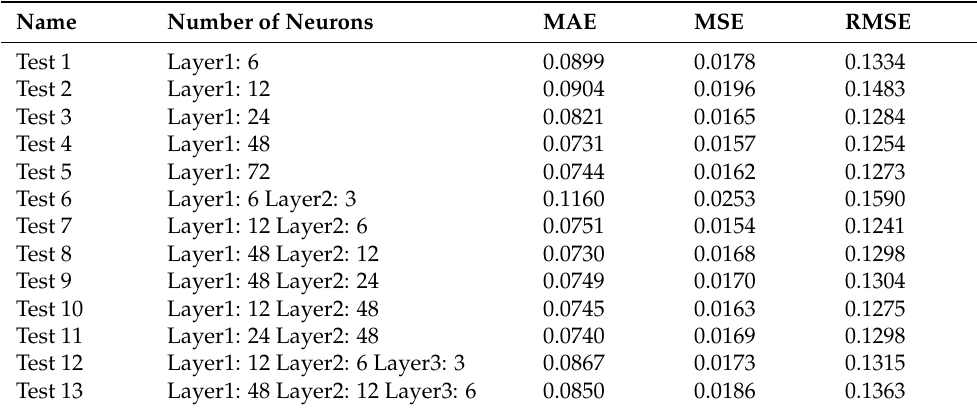
Table 3. Root Mean Square Propagation (RMSprop) algorithm test